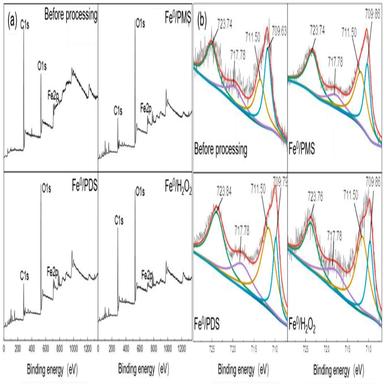
XPS patterns before and after the degradation of petroleum pollutants in OBDC by the Fe0 /PMS, Fe0 /PDS, and Fe0 /H2O2 systems: (a) full-range scan; (b) Fe 2p core level.